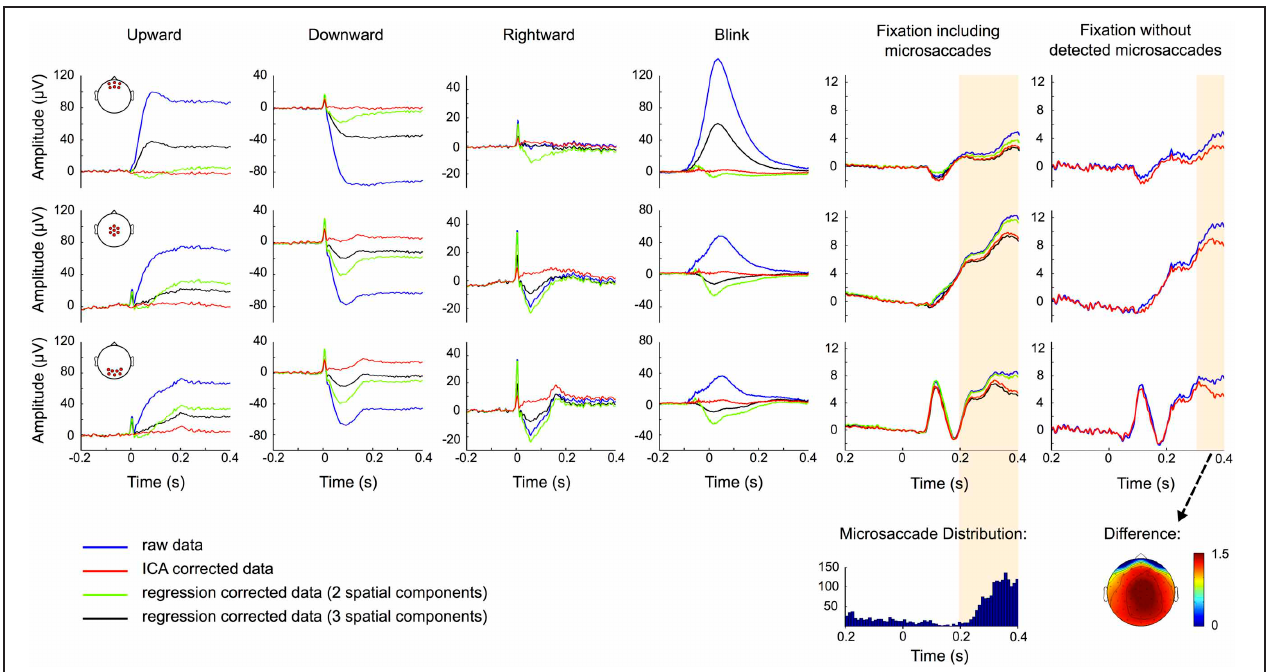
still clearly seen in occipital channels. However, ICA fails to entirely remove the spike potential at saccade onset but still reduces it substantially. In the fixation condition including microsaccades the raw and the ICA corrected data display significant differences (shaded area) in the time interval after 198ms, but the distribution of microsaccades over all trials (bottom row) suggests that a significant portion of these differences can be attributed to the reduction of microsaccade-related artifacts. This is supported by the observation that in fixation trials without detected microsaccades, the difference between raw and ICA corrected data is smaller and only becomes significant after 278ms. The topography of this difference resembles the one of the saccadic spike potential and may therefore be related to undetected